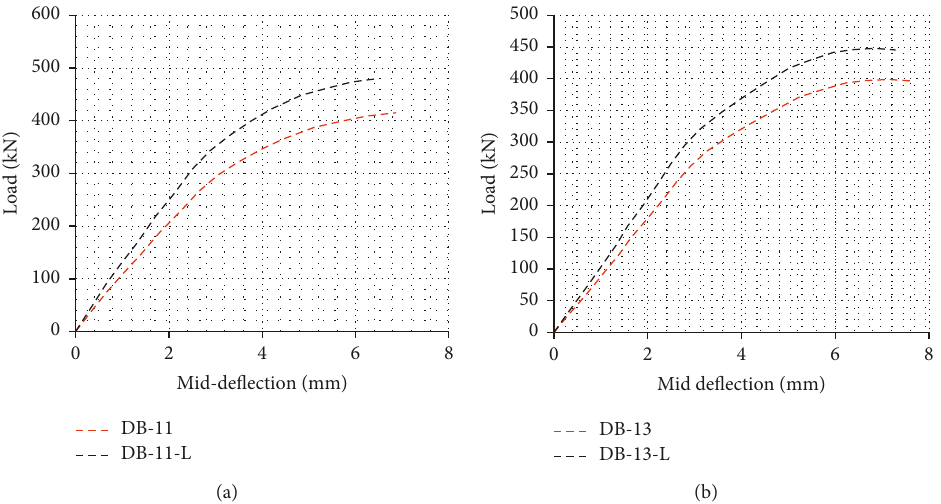
Figure 10: Load-deflection response curves with different longitudinal steel ratios of 0.02042 to 0.02608. (a) Beam with L/D and L/R ratios equal to 3 and 1.05, respectively, and (b) beam with L/D and L/R ratios equal to 3 and 1.57, respectively.